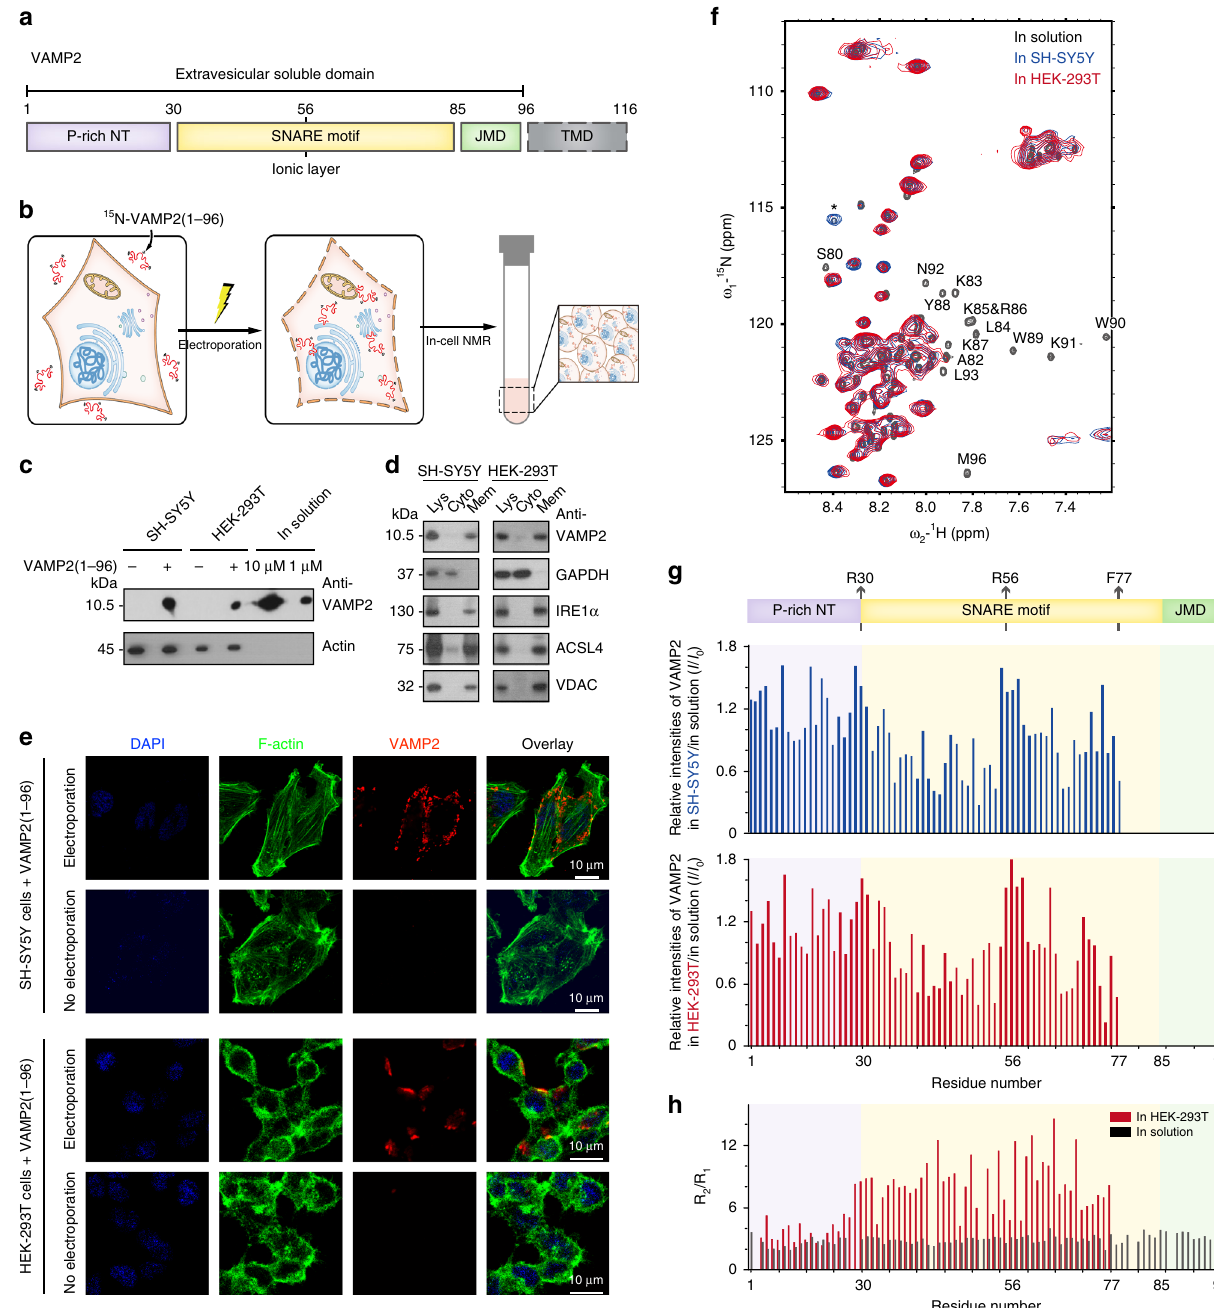
Fig. 1 Membrane association of VAMP2 extravesicular domain in mammalian cells by in-cell NMR spectroscopy. a Domain organization of VAMP2. P-rich NT: proline-rich N-terminal domain. JMD: juxta-membrane domain. TMD: transmembrane domain. R56 is conserved in the VAMP family which forms the zero ionic layer in the SNARE complex. b Scheme of in-cell NMR sample preparation. NMR-visible 15 N-VAMP2(1 – 96) was delivered into mammalian cells by electroporation. Un-delivered proteins were washed off before NMR signal acquiring. c Estimation of VAMP2 quantity in cells by immunoblotting. Cells prepared for NMR were diluted 10 times before loading on gels. Known concentrations of VAMP2(1 – 96) proteins were loaded as standards. d Sub-cellular localization of VAMP2(1 – 96) by fractionation and immunoblotting. Fractions of the total lysate (Lys), cytosol (Cyto) and membrane (Mem) were validated by immunoblotting with antibodies of GAPDH, IRE1 α , ACSL4, and VDAC to indicate cytosol, endoplasmic reticulum membrane, plasma membrane-associated membrane, and mitochondrial membrane, respectively. e Sub-cellular localization of VAMP2(1 – 96) by immuno fl uorescence staining. F-actin fi laments beneath cell membranes were stained by FITC-phalloidin. Nuclei were stained by DAPI. f Overlay of 2D 1 H- 15 N NMR spectra of VAMP2(1 – 96) in solution (black), SH-SY5Y cells (blue) and HEK-293T cells (red). Disappeared crosspeaks in cells were denoted. *The peak was not able to be assigned. g Residue-resolved relative NMR intensity ratios ( I / I 0 ) of VAMP2 (1 – 96) in cells to that in solution. Domain organization of VAMP2 extravesicular domain is indicated. h Residue-resolved ratios of 15 N transverse (R 2 , s − 1 ) to longitudinal (R 1 , s − 1 ) relaxation rates of VAMP2(1 – 96) in HEK-293T cells (red) and in solution (black). Source data are provided as a Source Data fi